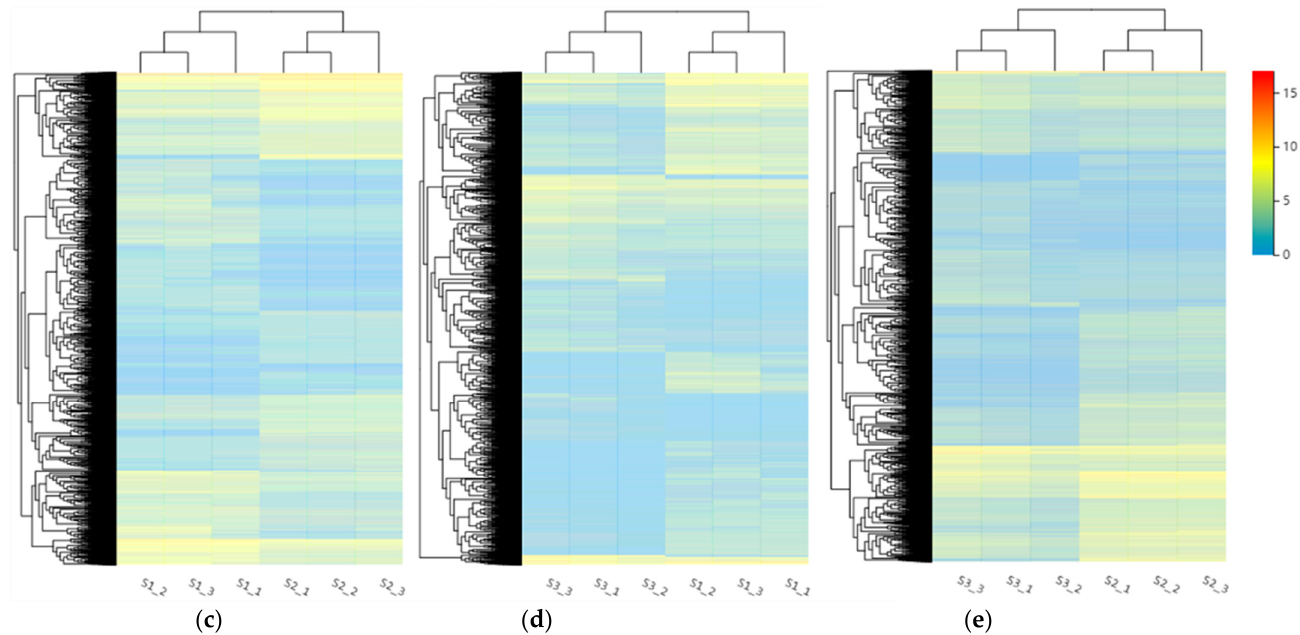
Figure 5 . Principal component analysis of different samples, hierarchical cluster, and distribution of DEGs. ( a ) principal component analysis of different samples; ( b ) Venn diagram of DEGs; ( c ), ( d ) and ( e ) represent the cluster heat map in S1 vs. S2, S1 vs. S3 and S2 vs. S3, respectively.